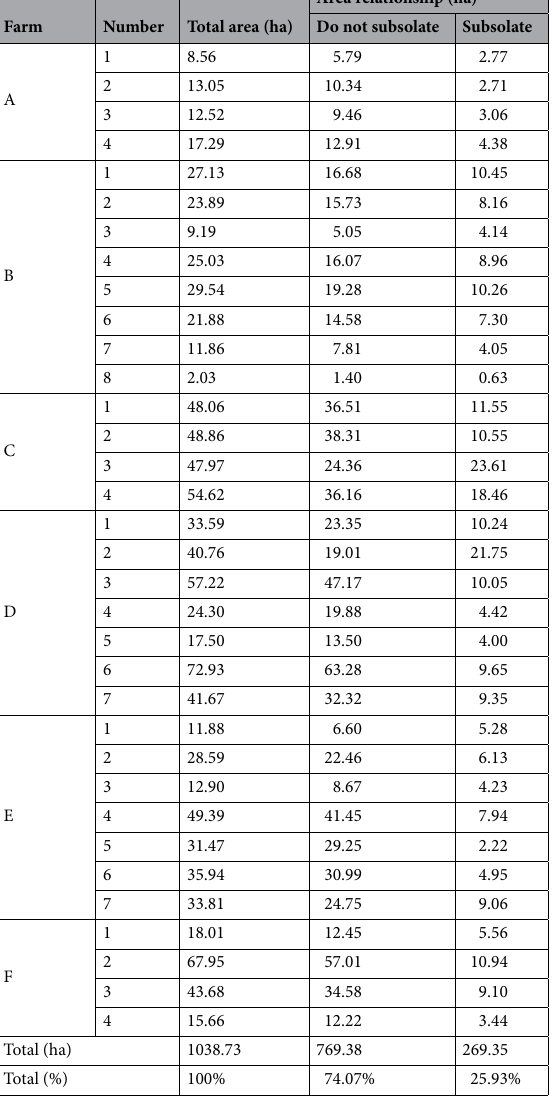
Table 2. Summary of the areas evaluated considering topographical